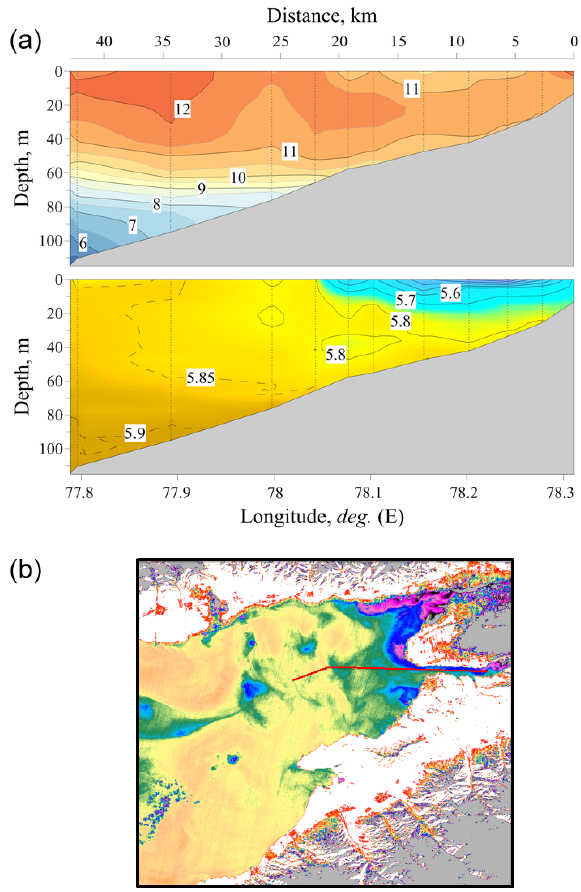
Figure 4. (a) Distribution of temperature ( ◦ C, a ) and salinity (gkg − 1 , b ) in a longitudinal section following the ancient bed of the Jyrgalan River on the eastern shelf (green bullets in Fig. 1) on 1–2 November 2016. (b) Landsat infrared satellite image at 60m resolution obtained on the same day (courtesy of Alexei Kouraev, LEGOS, France). Red line corresponds to the section where the in situ measurements shown in Fig. 4a were taken.